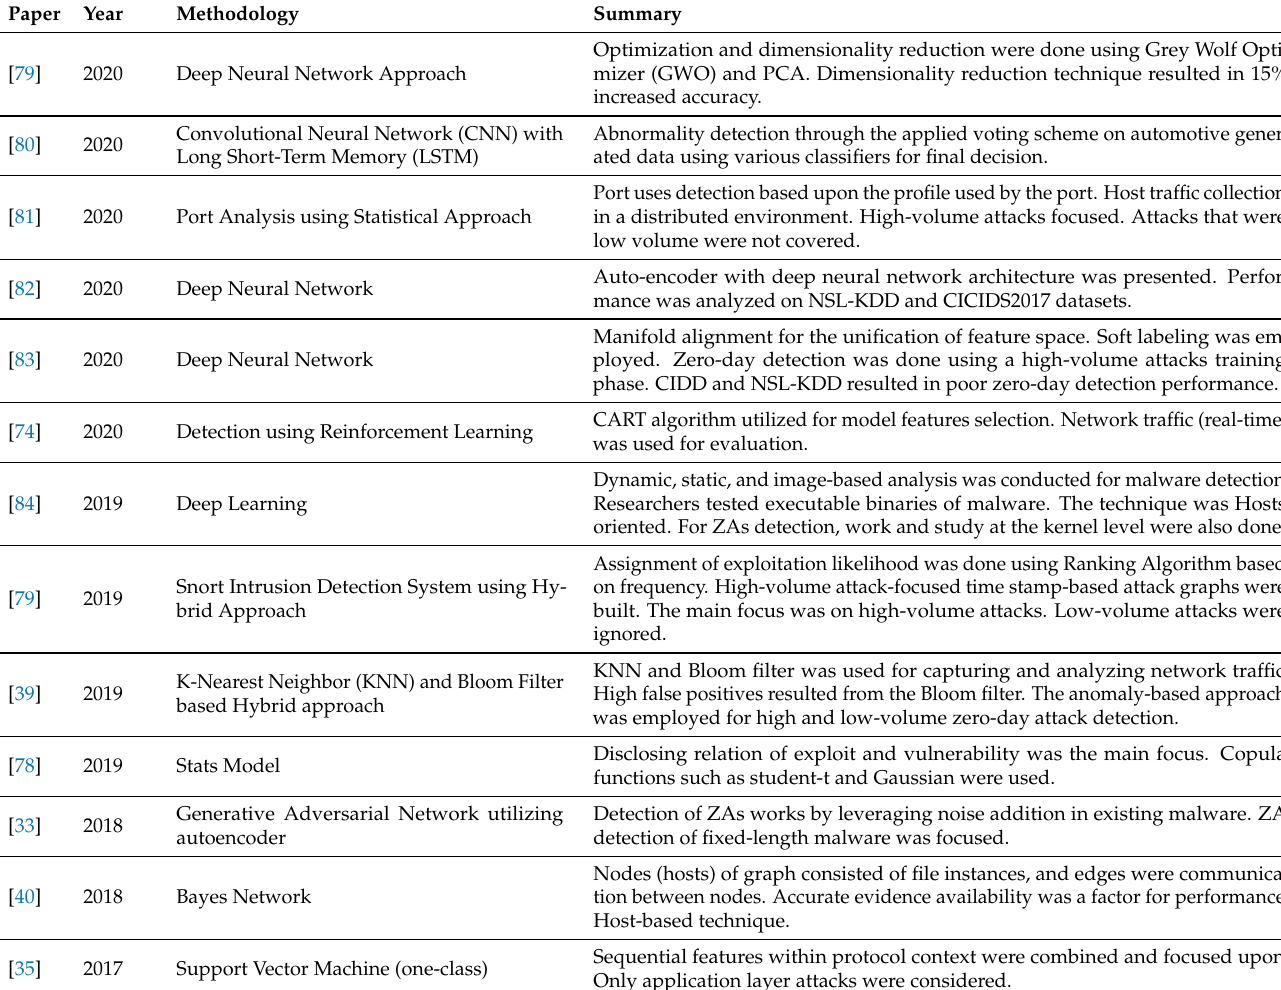
Table 2. Analysis of zero-day attack detection